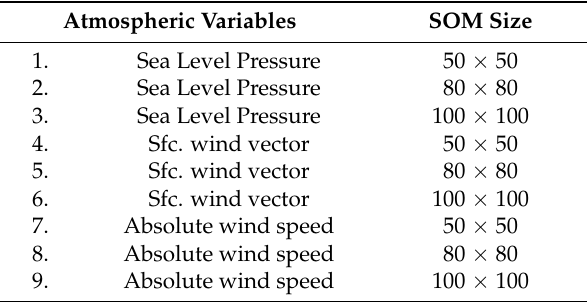
Table 1. Parameters used in the nine